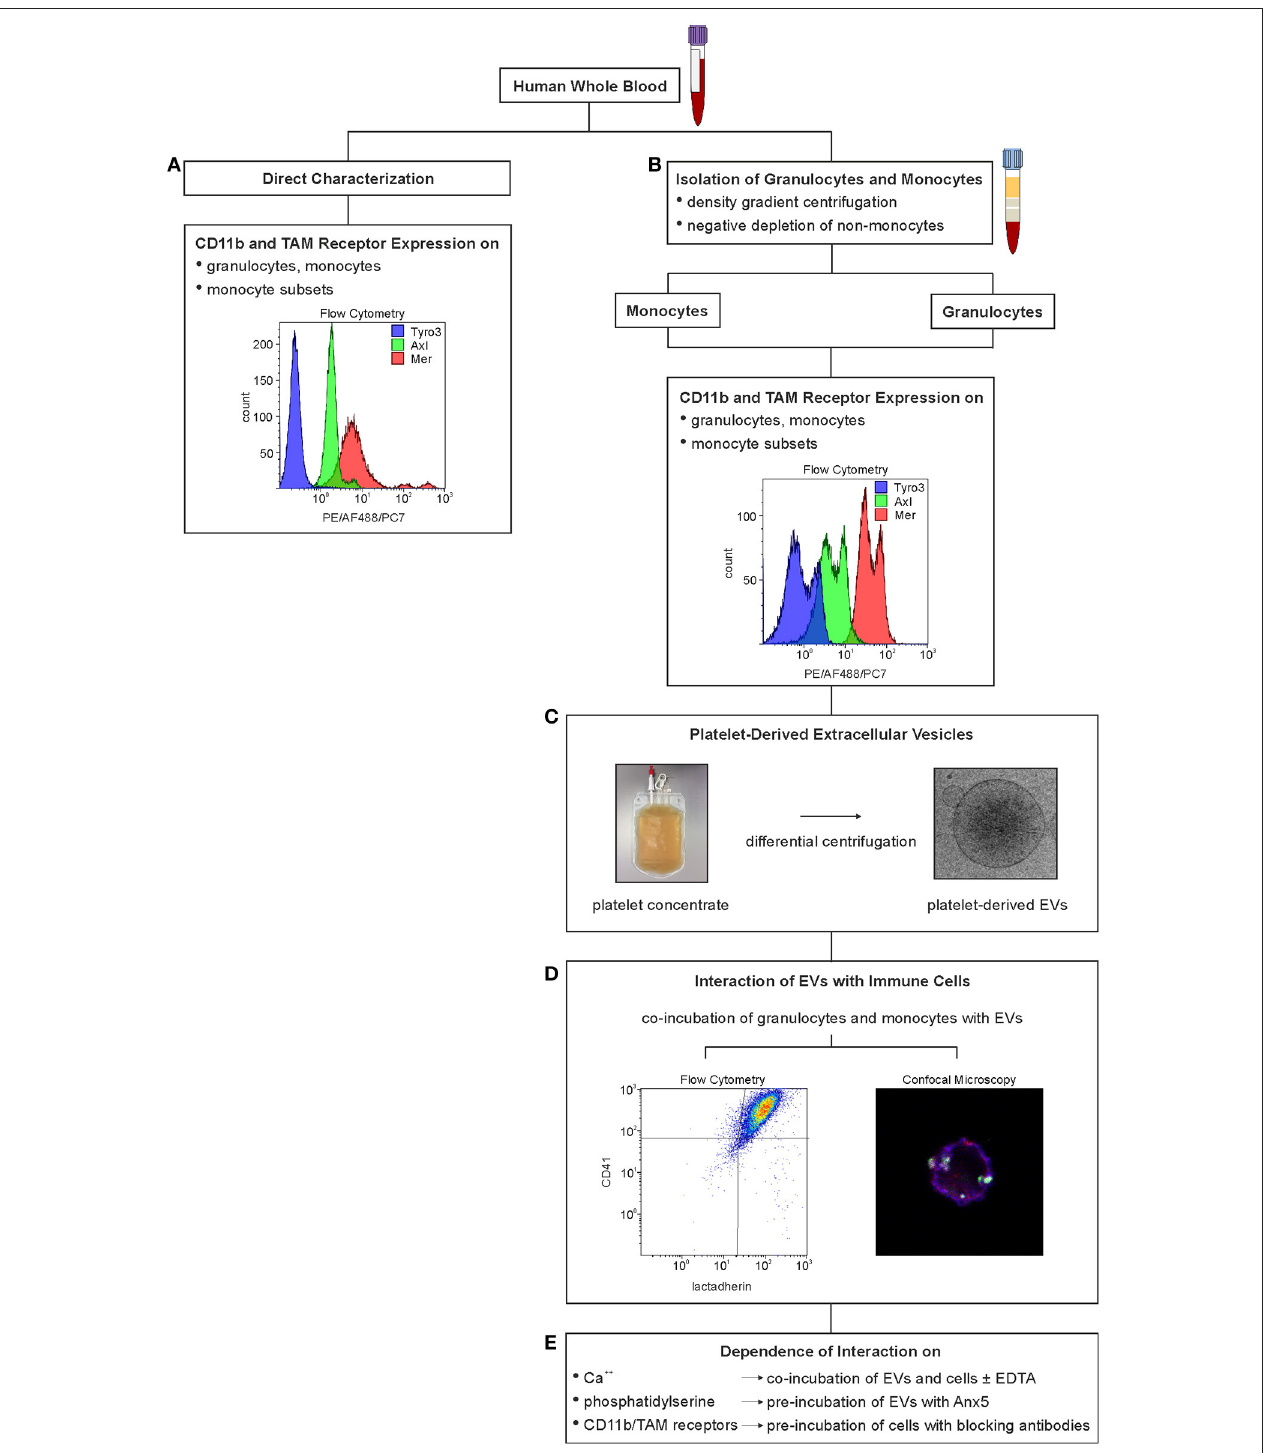
FIGURE 1 | Experimental set-up to characterize the interaction of immune cells with platelet-derived extracellular vesicles. Expression of TAM receptors and of activated CD11b on immune cells was either characterized directly in whole blood using flow cytometry (A) or on isolated granulocytes and monocytes (B) . Platelet-derived EVs were isolated from medical grade platelet concentrates (C) , and their interaction with immune cells was investigated by co-incubation with granulocytes and monocytes isolated from whole blood (D) . The effect of Ca ++ , phosphatidylserine, activated CD11b, and TAM receptors on the interaction of EVs and immune cells was assessed by addition of EDTA, by pre-incubation of platelet-derived EVs with Anx5, and by pre-incubation of isolated immune cells with anti-CD11b and anti-TAM antibodies, respectively (E) .